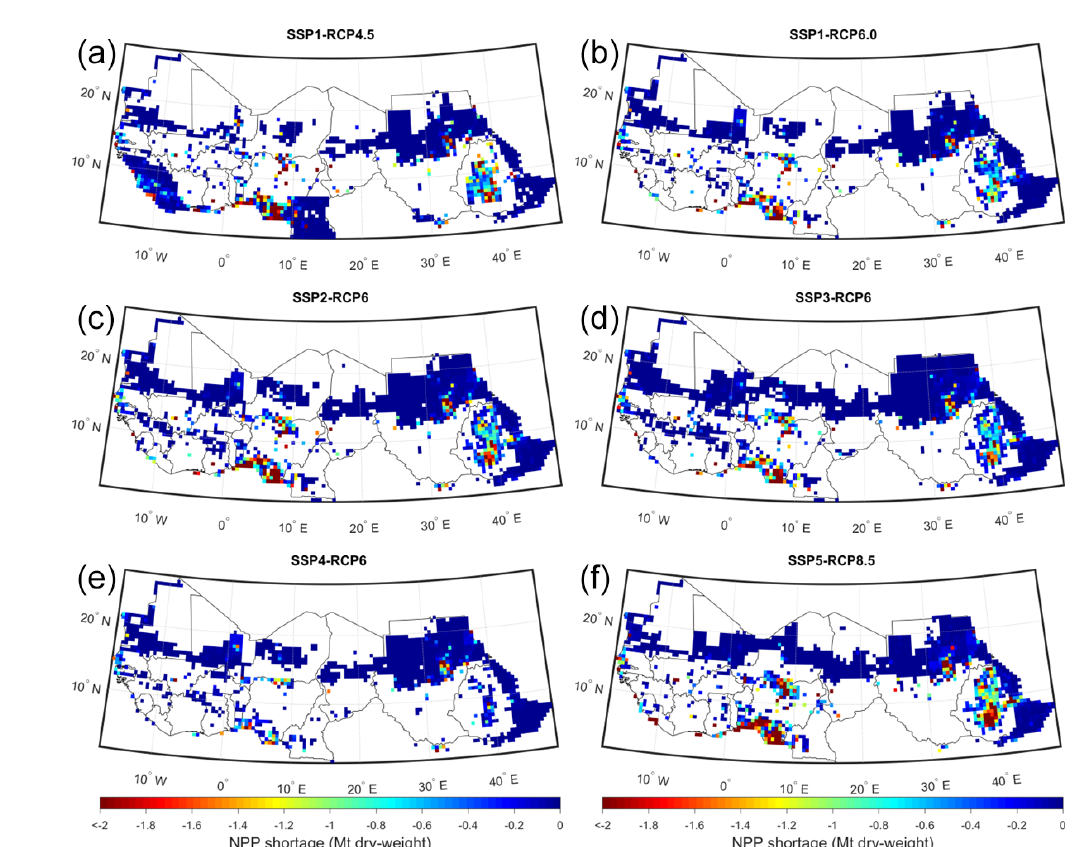
Figure B1. Spatial distribution of NPP shortage in 2050 for the six most likely SSP–RCP combinations. The future socio-economic and climatic scenarios are ordered in the panels as follows: (a) SSP1-RCP4.5, (b) SSP1-RCP6.0, (c) SSP2-RCP6.0, (d) SSP3-RCP6.0, (e) SSP4- RCP6.0, and (f) SSP5-RCP8.5.